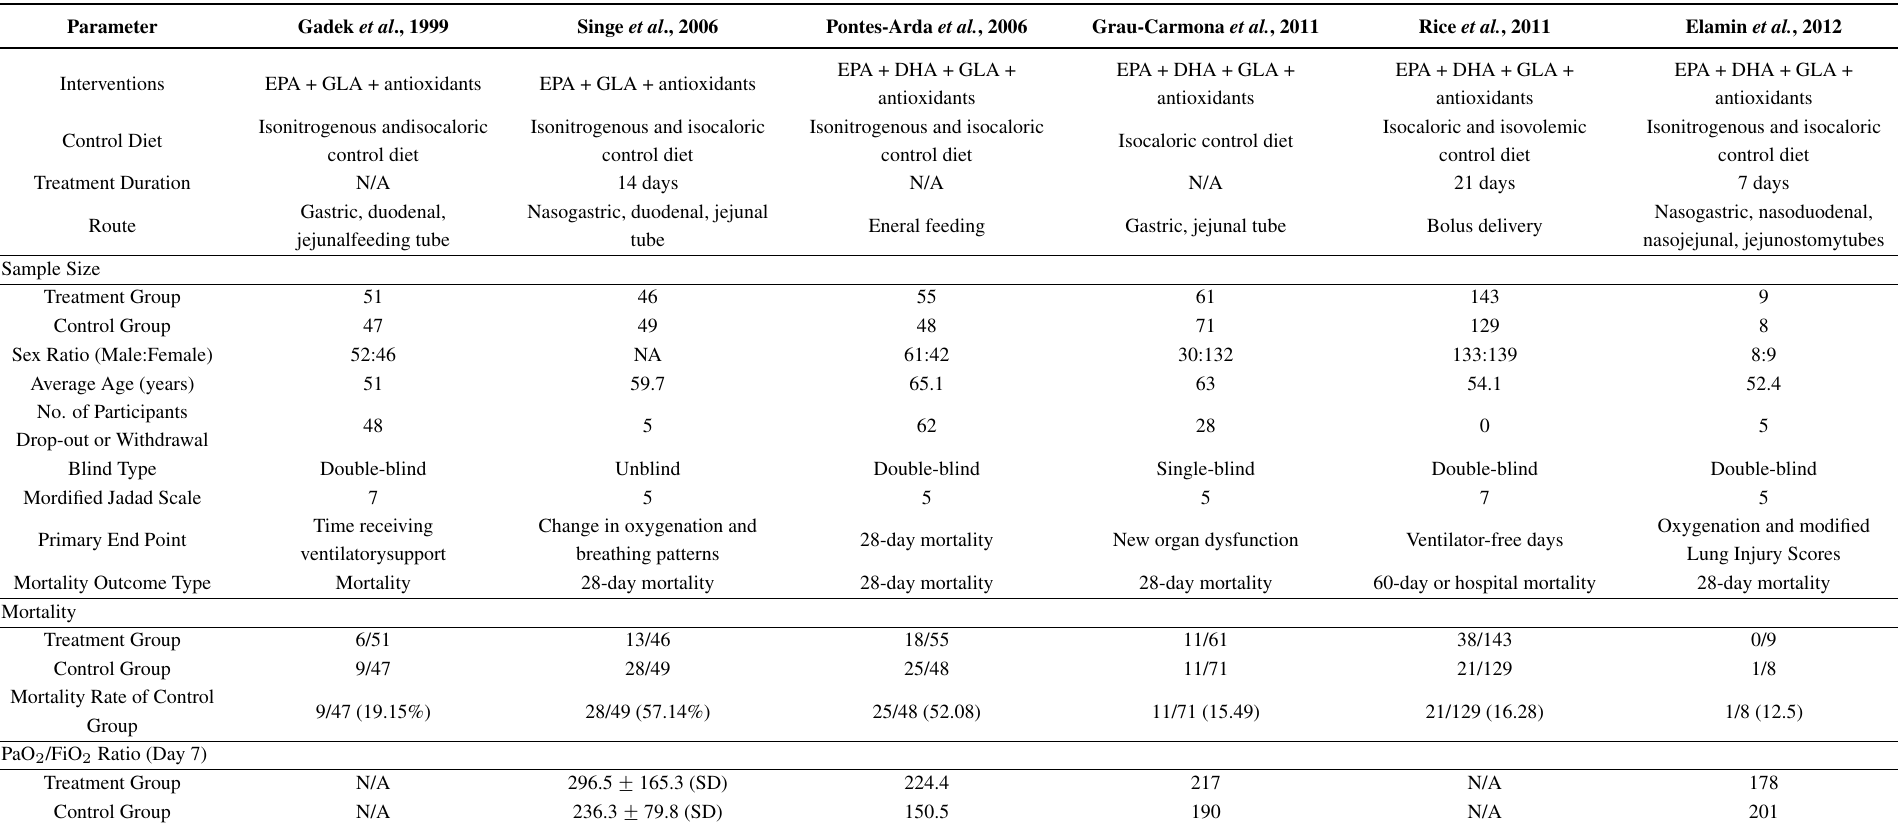
Table 1. Characteristics of included